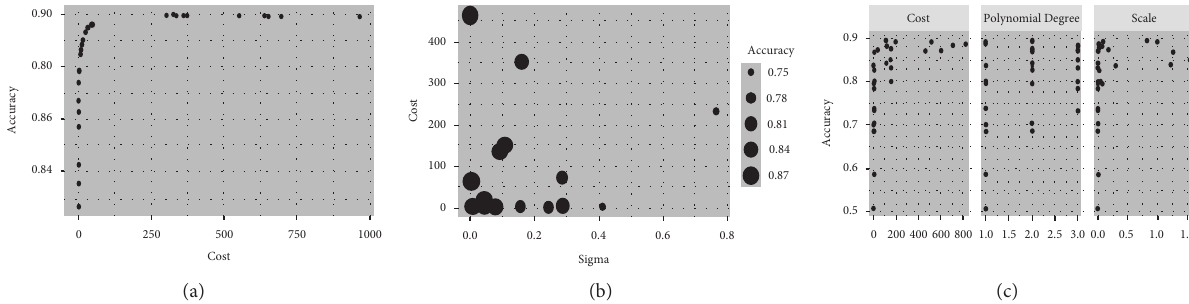
Figure 6: Optimized parameter selection using the grid search technique for SZSE component index with (a) linear kernel, (b) radial basis kernel, and (c) polynomial kernel of degree